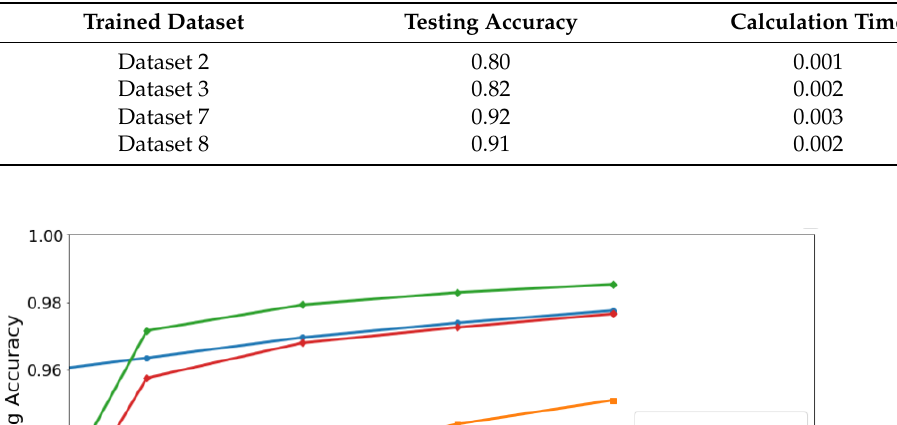
Table 3. Comparison with other datasets for testing accuracy and calculation time.